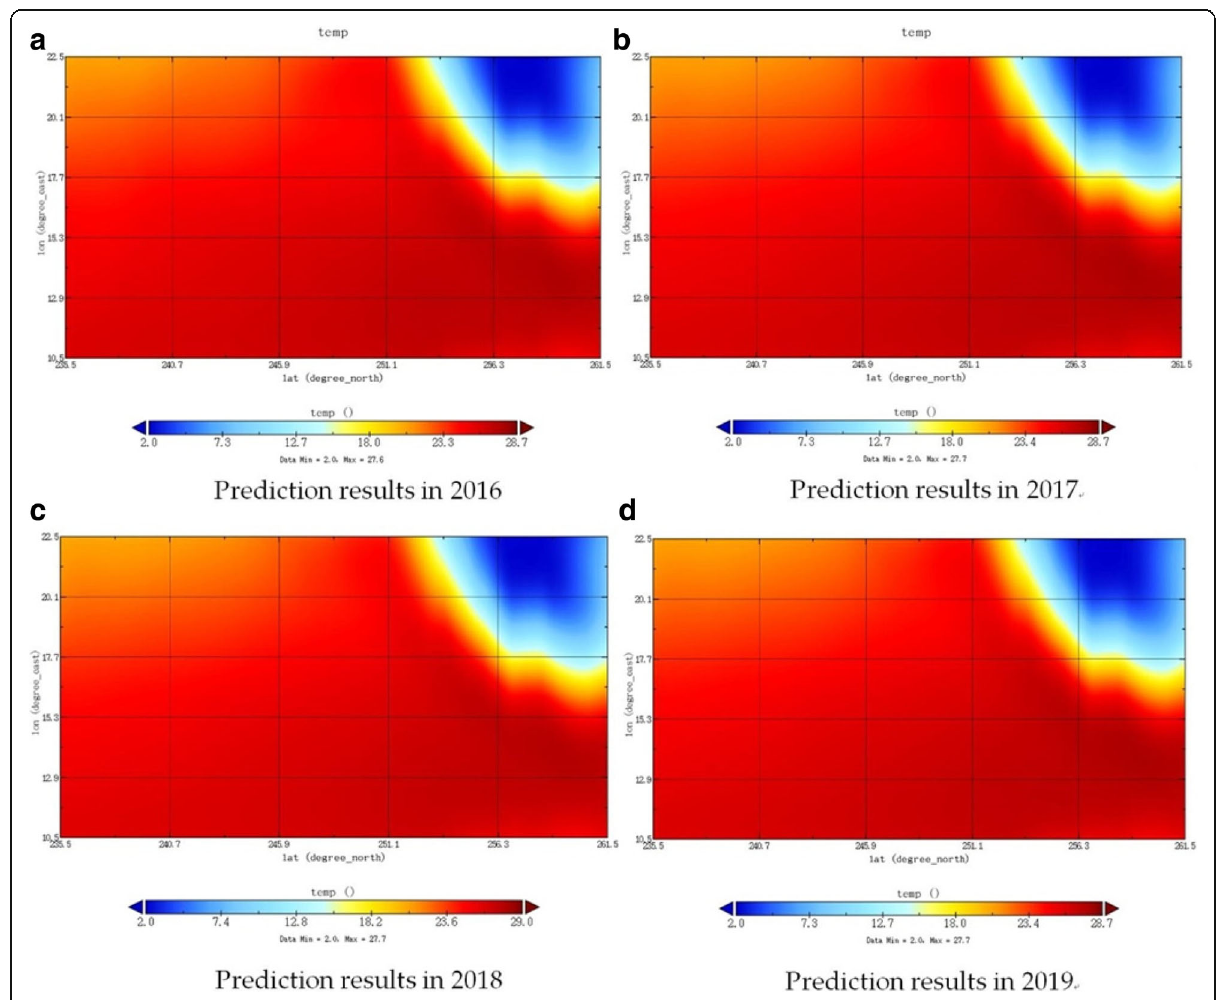
Fig. 7 Prediction of changes in the thermocline boundary in 2016 ( a ), 2017 ( b ), 2018 ( c ) and 2019 ( d